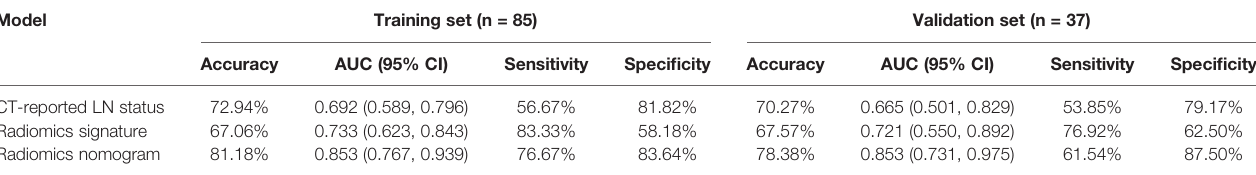
TABLE 4 | Performances of the CT-reported LN status, radiomics signature, and radiomics nomogram.